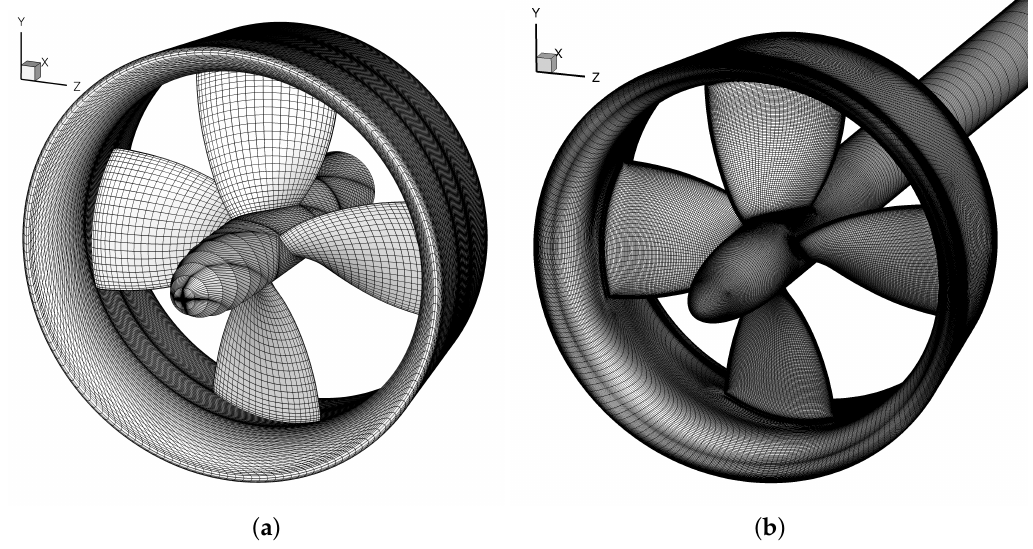
Figure 4. Overview of the surface grids used for the inviscid calculations with PROPAN ( a ) and RANS calculations with ReFRESCO ( b ). Table 2. Variation of open-water characteristics with different grid sizes compared to the finest grid with M denoting million. RANS computations at J =